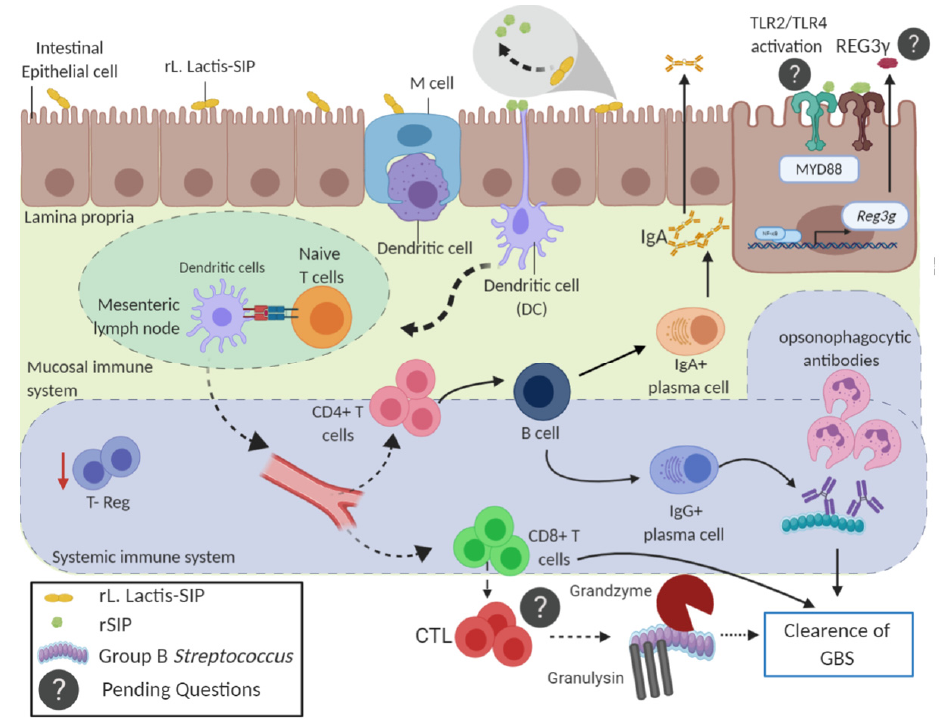
Figure 6. Scheme of the possible humoral and cellular mechanism involved in decreasing GBS colonization by rL. lactis -SIP oral vaccination. The function of the oral rL. lactis -SIP on stimulation of intestinal dendritic cells that can induce a protective cellular and humoral immunity against group B Streptococcus . Following the uptake of SIP from L. lactis , intestinal dendritic cells migrate to lymphoid tissue to prime naive CD4 + T cells and CD8 + T cells. Then, T helper cells stimulate IgG and IgA antibody production by B cells. SIP-specific antibodies can be neutralizing and prevent GBS infection. The contribution of CD8 T cells in reducing vaginal colonization remains unclear, as does the way in which SIP could modulate the innate immune response in the intestinal microbiota.